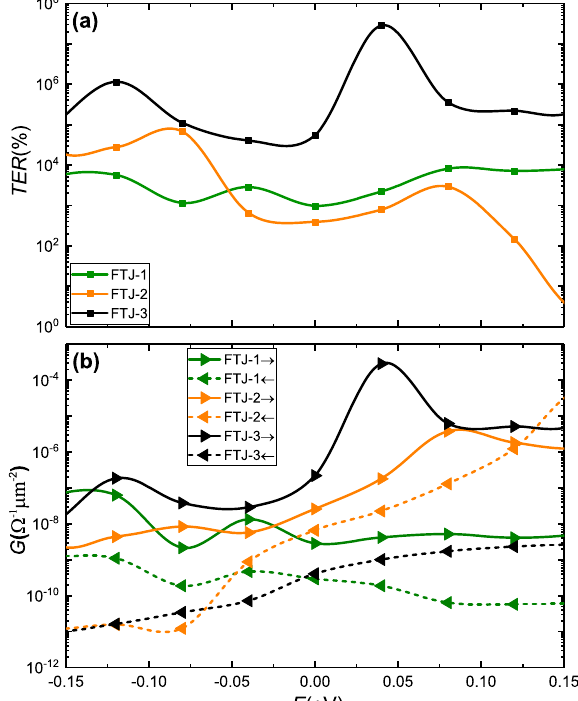
Fig. 5 TER and conductance G calculated by fi rst-principles. a TER of the FTJs as a function of energy E around Fermi level. b G per lateral area of FTJs as a function of energy E for polarization pointing right (solid arrow) and left (dotted arrow). The Fermi energy is at zero. Green, orange, black lines represent FTJ 1 – 3,